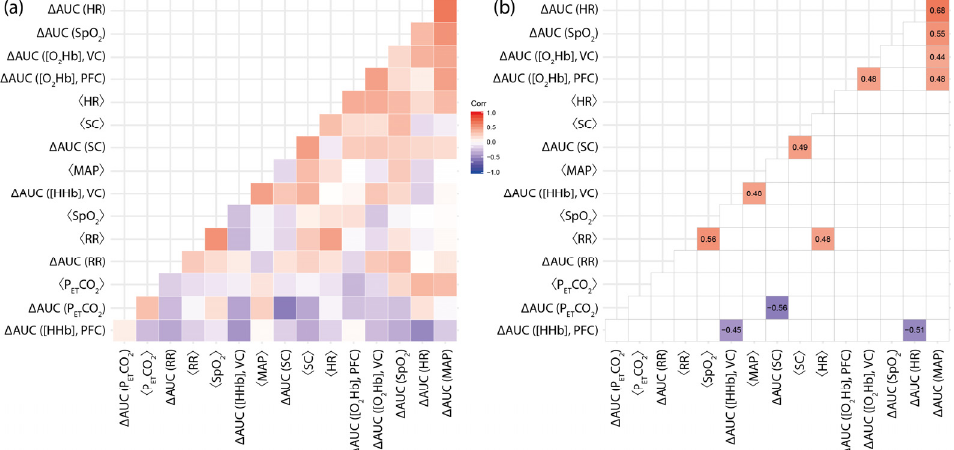
Figure 2. Correlation matrix of the ∆ AUC and mean baseline values of all biosignals with ( a ) all values of the correlation coefficient shown and ( b ) with only statistically significant ( p < 0.05) correlations (the numerical values refer to the correlation coefficient). All statistically significant correlations remained significant after multiple-comparison correction (false discovery rate correction).